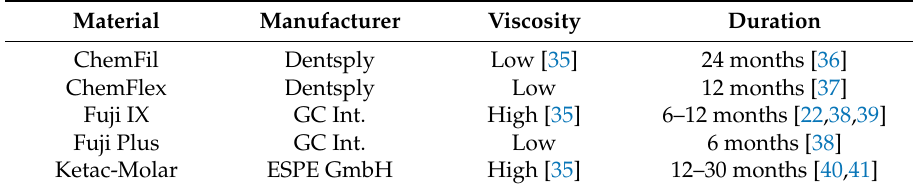
Table 1. The different types of glass ionomer cement (GIC) used for atraumatic restorative treatment